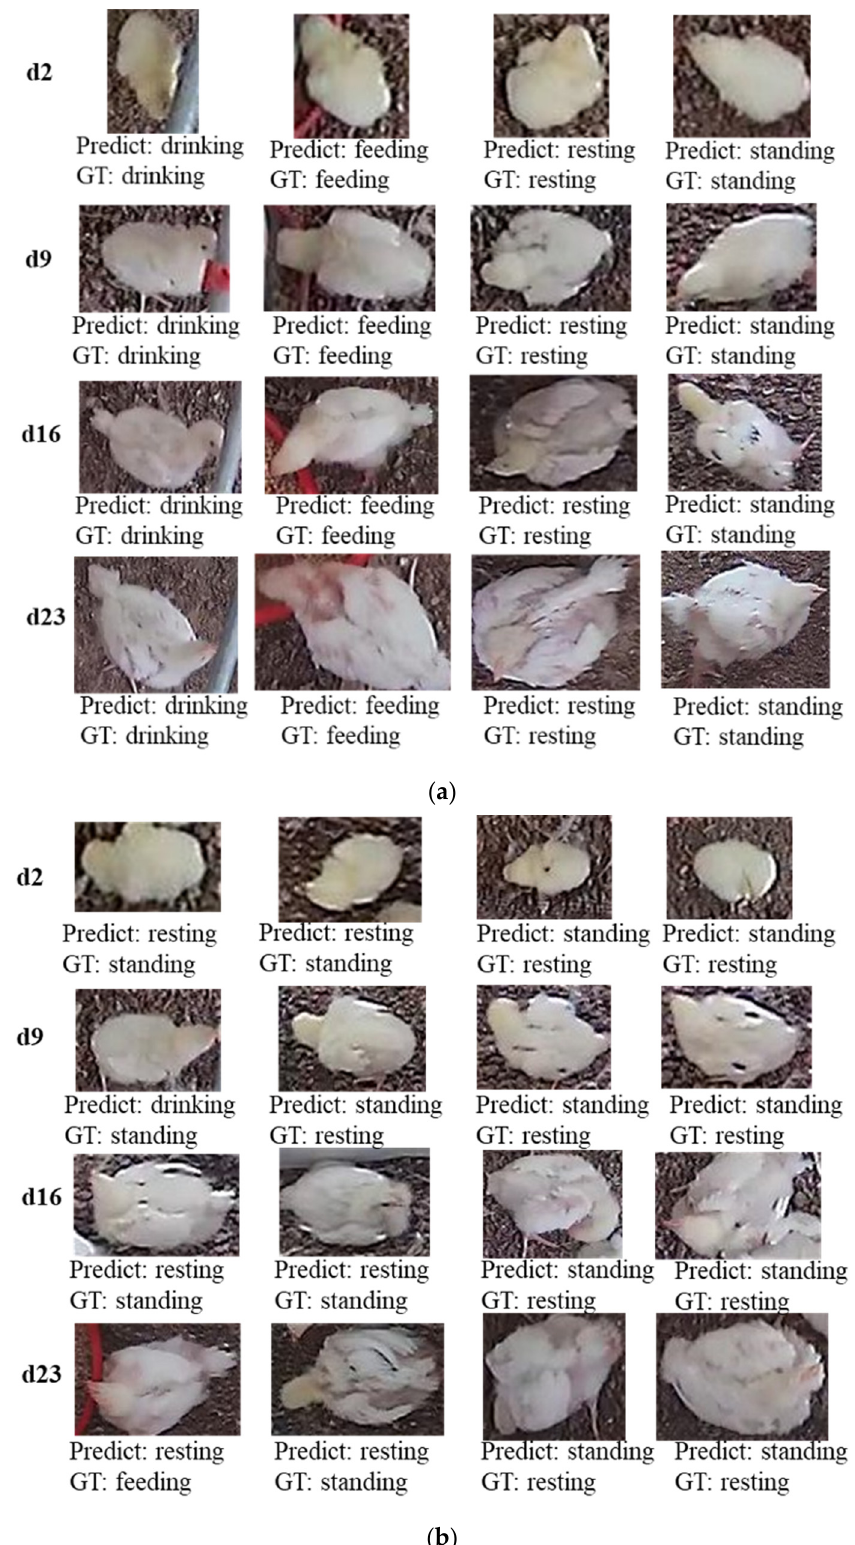
Figure 3. Behavior classification results of the Densenet-264 in broilers dataset. ( a ) True classification examples, ( b ) False classification examples.